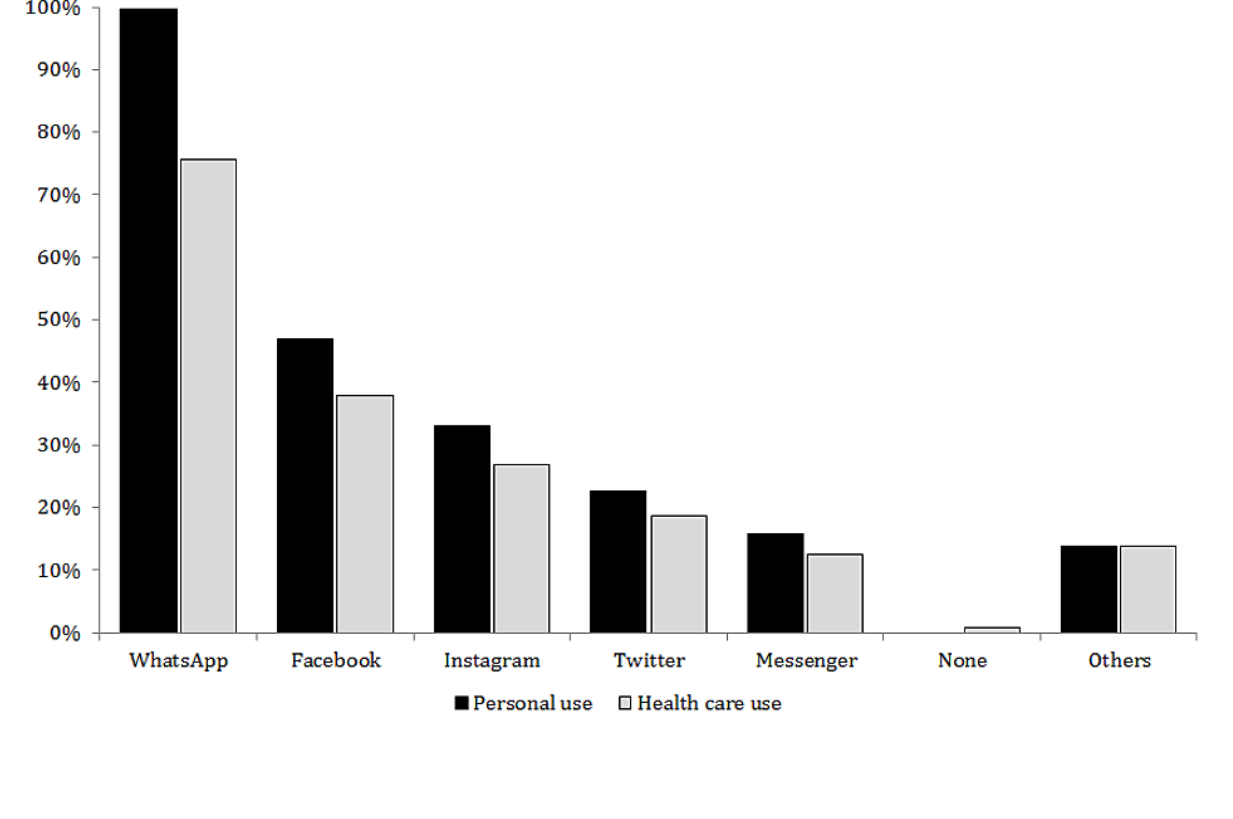
Figure 2. Percentage of respondents using the various apps for personal and professional